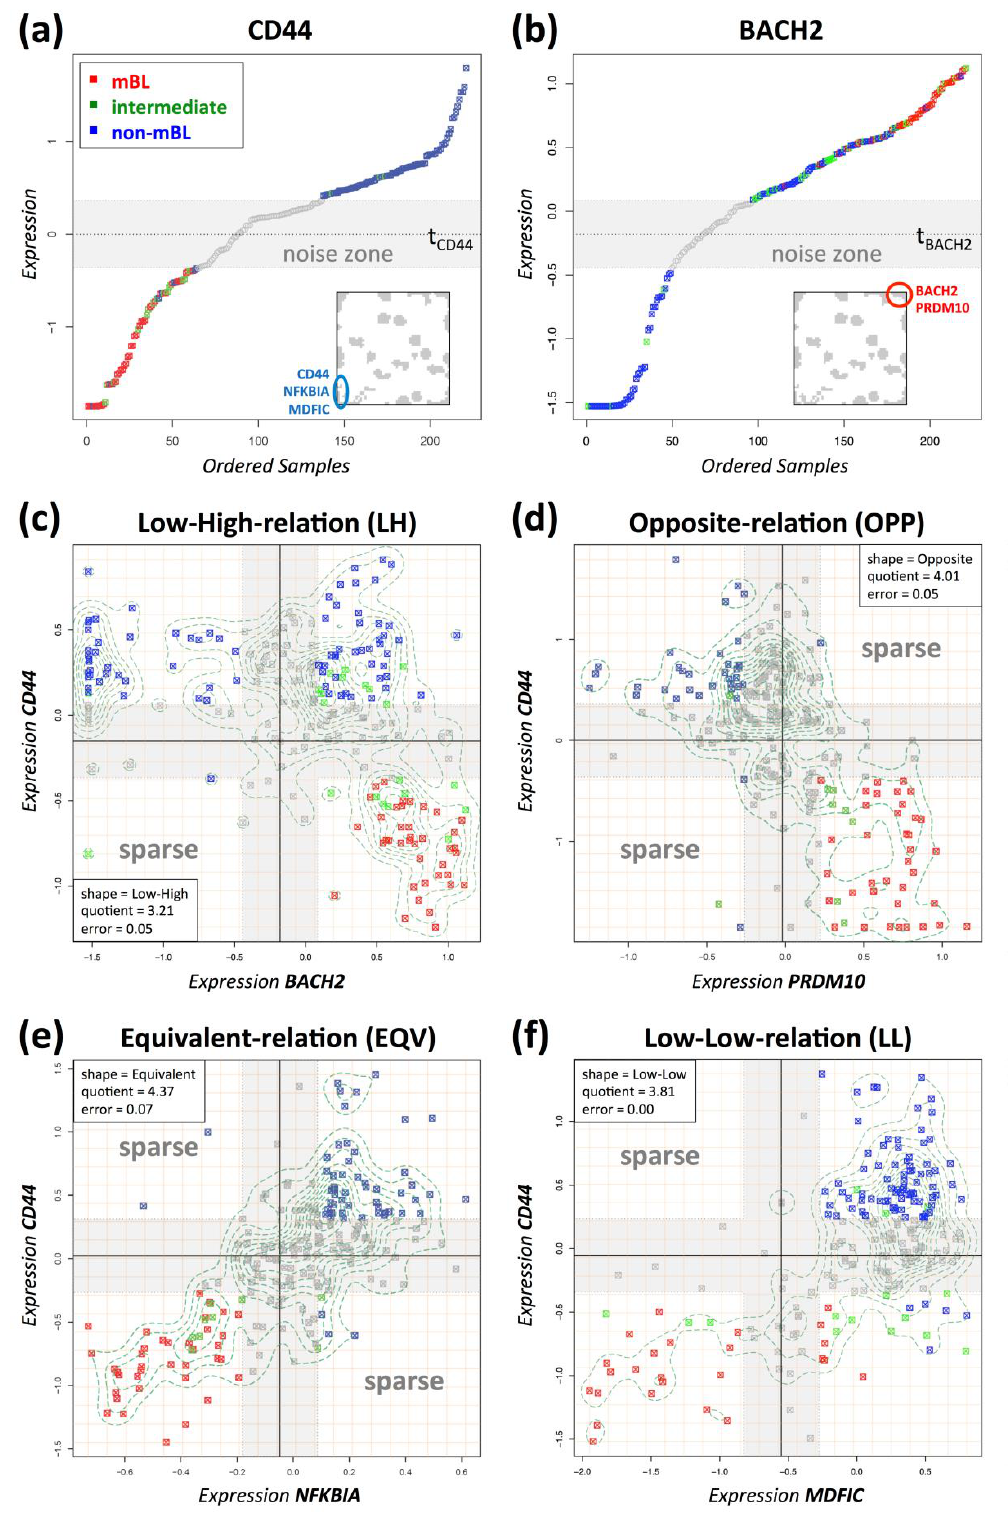
Figure 5: Boolean implication analysis for selected mBL- and non-mBL signature genes. The icons show that these genes are located within the regions of the spot-modules mBL-UP and non- mBL-UP (see small maps within panel b and a, respectively and see Figure-4b and c). Ordered expression profiles of non-mBL-UP gene CD44 (panel a) and of the mBL-UP gene BACH2 (panel b). Pairwise scatterplots of genes from different (panels c and d) and from the same signature (panels e and f) can be assigned to Boolean implications of the opposite- and of the equivalence- type, respectively. (R package KernSmooth version 2.23-7 is used for the contour lines in Figure- 5 and 6